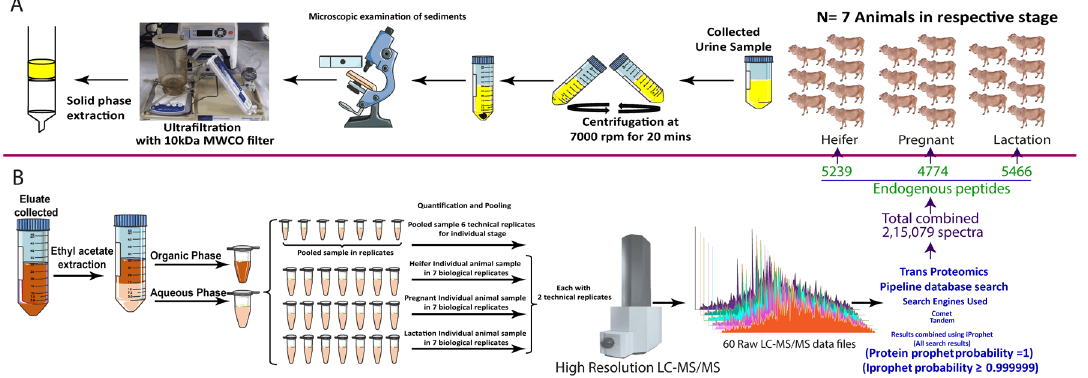
Figure 1. ( A ) Flow diagram showing collection and processing of samples from three different physiological states of Sahiwal cow followed by separation of small-sized peptides (<10 kDa) by ultrafiltration assembly and its extraction by C18 solid-phase extraction method. ( B ) The solid phase extraction (SPE) method. The bound analytes in the column were first eluted in 60% ACN, 0.1% TFA followed by the extraction of peptides in the aqueous phase using ethyl acetate. An equal amount of peptides from each sample (biological replicates) was pooled group-wise and quantified, for nLC-MS/MS analysis in triplicate (technical